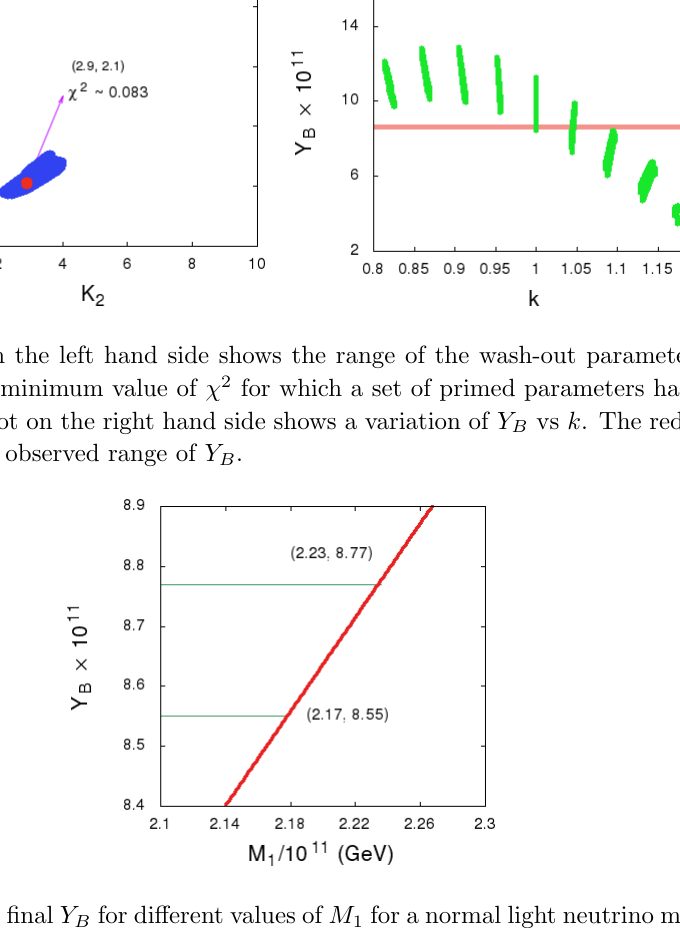
= 0 : 083). In principle one can take min